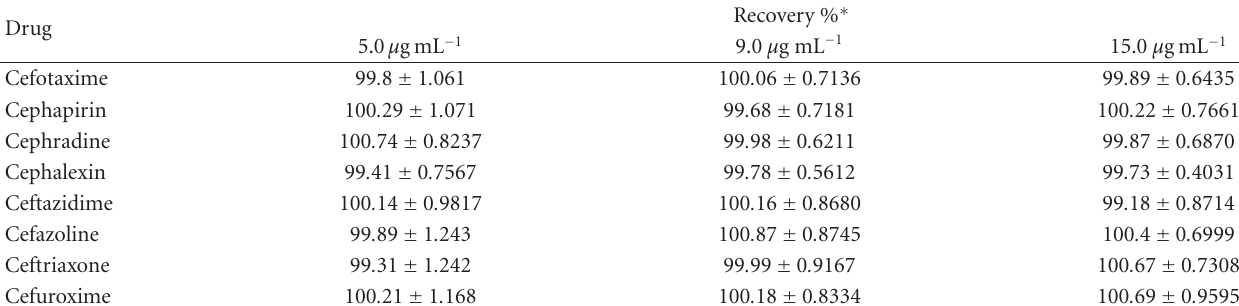
Table 4: Evaluation of accuracy of the analytical procedure using initial rate method.